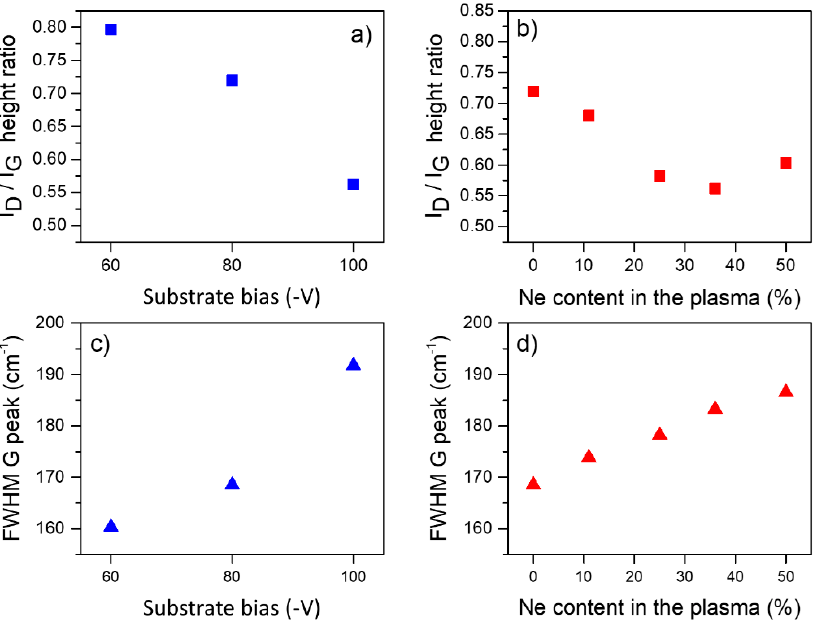
Figure 8. I G / I D height ratio ( a , b ) and full width at half maximum of the G band (FWHM G ) ( c , d ) as a function of the substrate bias and the Ne content in the plasma.